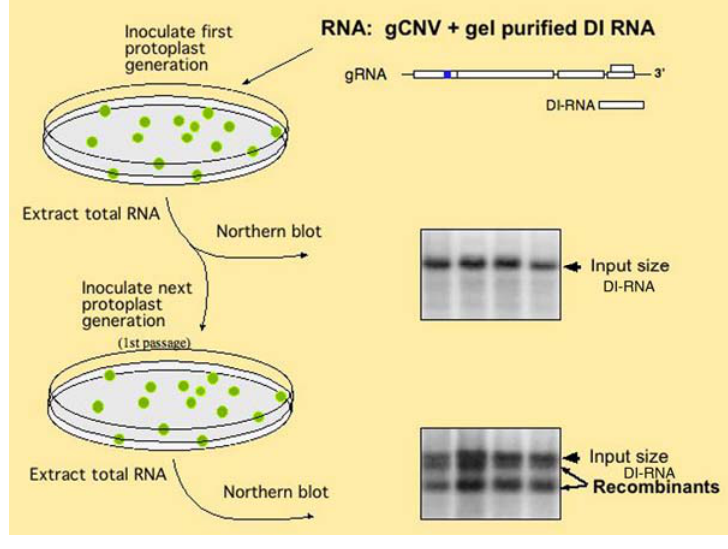
Figure 2 . Experimental scheme to test DI-RNA evolution in plant protoplasts. Generation of DI-RNA recombinants are tested via using the total RNA extract from the first protoplast samples for electroporation of the second batch of protoplasts (1st passage). The images on the right show Northern blot analysis of the total RNA extracts used to detect the original DI-RNA and the recombinants